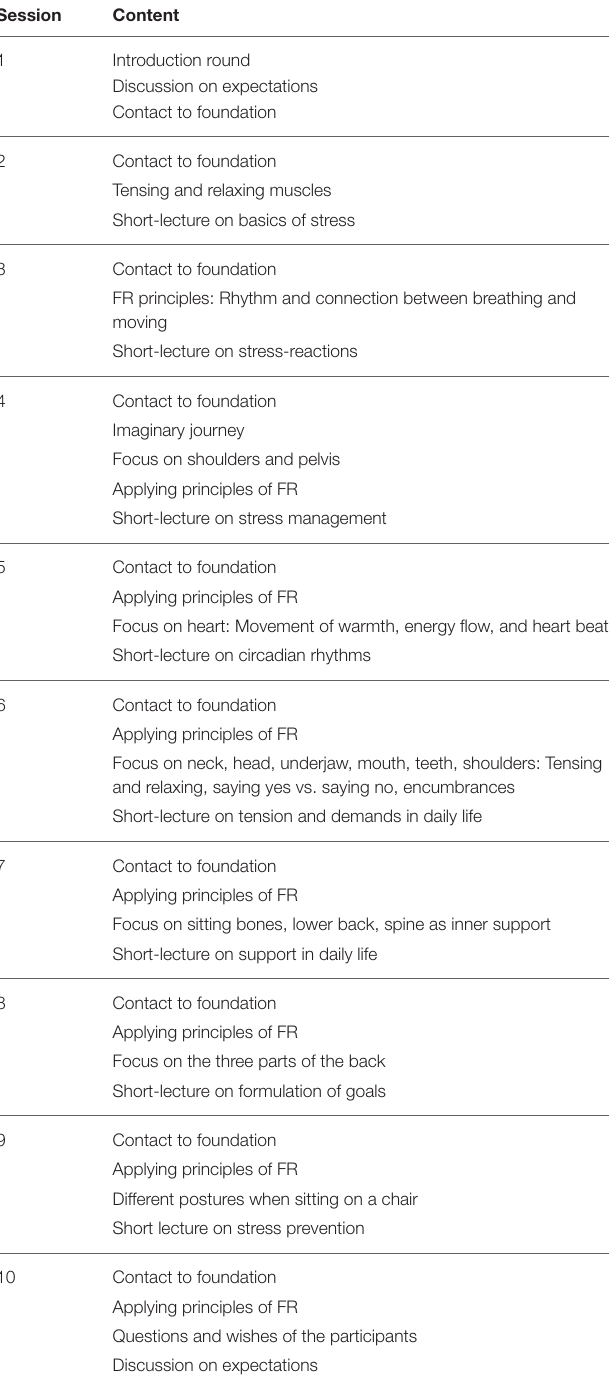
TABLE 1 | Content of functional relaxation combined with